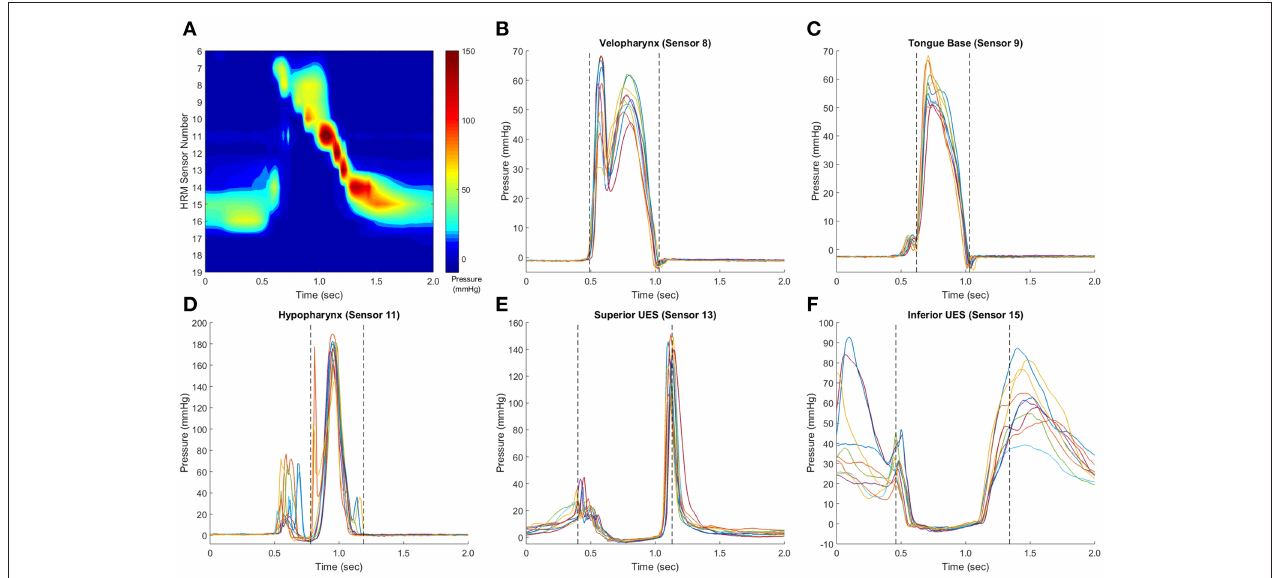
FIGURE 3 | Identification of pressure waveform boundaries. Sample swallows from a healthy 32 year-old female, with a representative spatiotemporal plot (A) . In pressure waveforms in the velopharynx, tongue base, and hypopharynx, pressure onset was defined as the first of the set of waves to rise from baseline pressure at a rate ≥ 2 mmHg/0.01s, and pressure offset was defined as the last waveform to fall to baseline a rate equal to or ≥ 2 mmHg/0.01s (B,C) . Hypopharynx propagation pressures were separated from non-clearance pressures (D) . In the upper esophageal sphincter (UES), the waveform boundary started when the first waveform fell at a rate ≥ 2 mmHg/0.01s and ended when the last waveform rose at a rate ≥ 2 mmHg/0.01s (E,F) . This rate was determined as the pressure resolution of the ManoScan ESO system is 2 mmHg and the data output is 100Hz. Pressure waveform boundaries were automatically detected by a customized Matlab